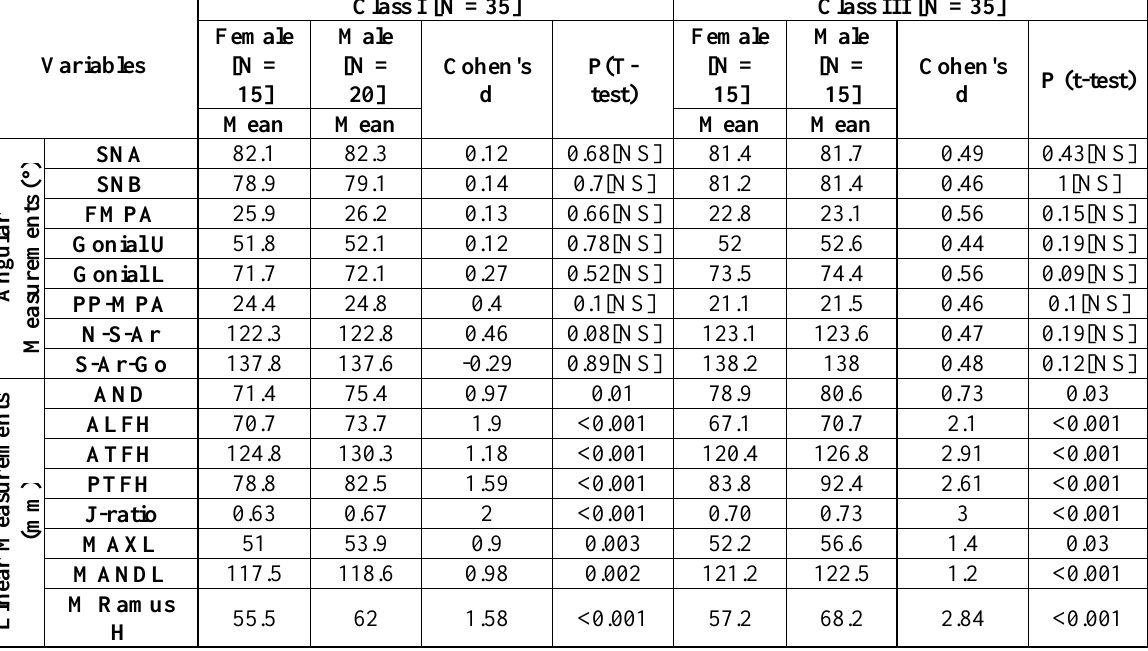
Table 2: Gender Effect on Selected Measurements Stratified by